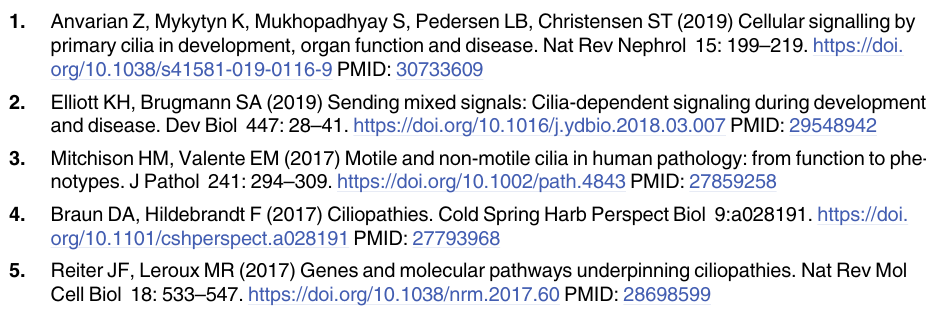
S3 Fig. Analysis of NPHP1 and NPHP4 in the knocksideways assay. (A-C) NPHP1-mCh- mito localizes to the mitochondrial surface but fails to recruit the inner ring nucleoporins (A) GFP-Nup35 and (C) Nup155-EGFP3 or the outer ring nucleoporin (C) GFP-Nup133 to the mitochondrial surface. (D-F) NPHP4-mCh-mito localizes to the mitochondrial surface but fails to recruit the inner ring nucleoporin (D) GFP-Nup35 and the outer ring nucleoporin (F) GFP-Nup133 but does recruit the inner ring nucleoporin (E) Nup155-GFP to the mitochon- drial surface. Scale bars, 10 μ m. Yellow text indicates the number of cells positive (pos.) or neg- ative (neg.) for a knocksideways interaction. S4 Fig. BiFC analysis of NPHP4 and NPHP5 with nucleoporins. (A) Co-expression of Cer- NPHP4-YC with the inner ring nucleoporin YN-myc-Nup35 results in a positive BiFC interac- tion in 4/30 cells. (B) Co-expression of Cer-NPHP5-YC with the inner ring nucleoporin YN- myc-Nup35 results in a positive BiFC interaction in 8/24 cells. Scale bar, 5 um. Yellow text in the top right corners indicate the number of cells scoring negative or positive for a BiFC inter- action across two independent experiments. Yellow arrows indicate the base of the primary cil-